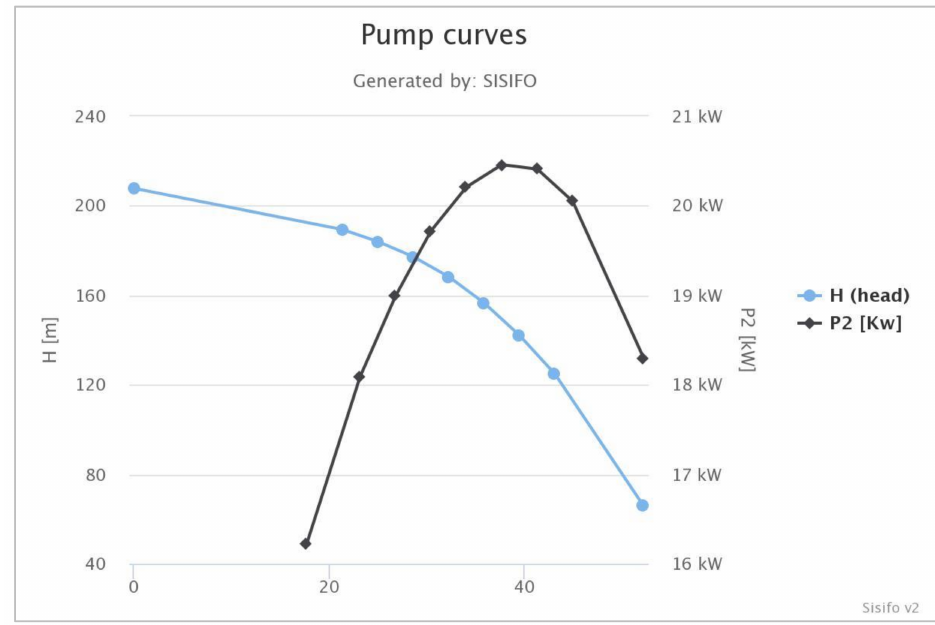
Figure 4. Pump motor characteristics.